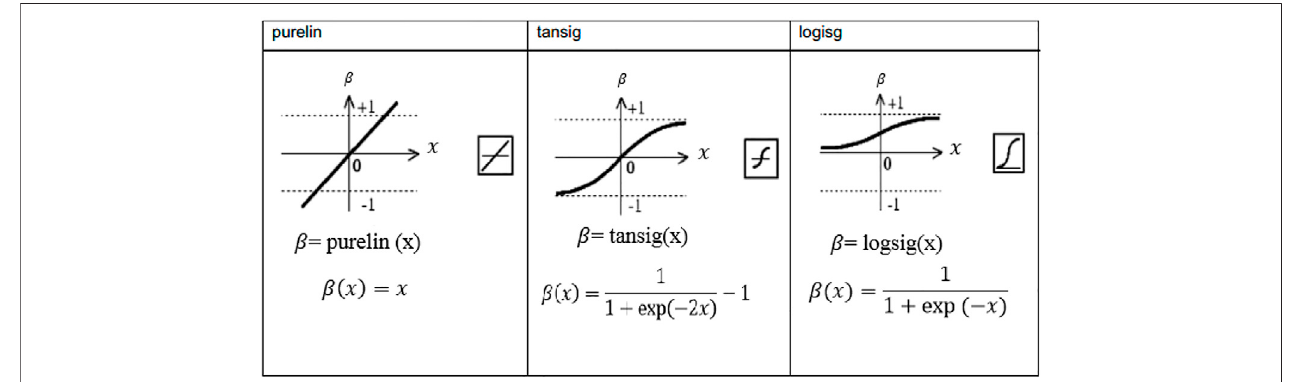
FIGURE 1 | Schematical representation of transfer functions (Mozaffari et al., 2017).